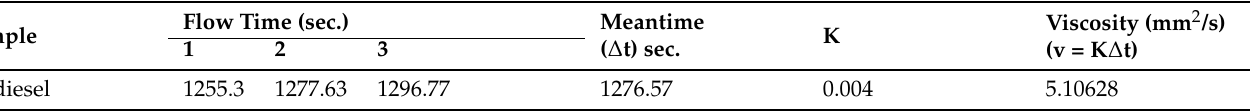
Table 4. Viscosity measurement by using CANNON-FENSKE